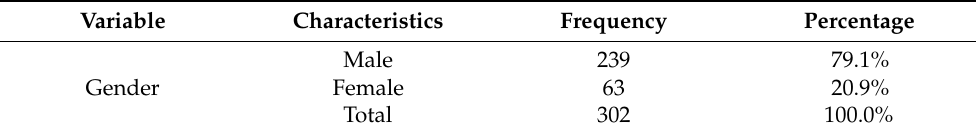
Table 1. Showing characteristics, frequencies, and